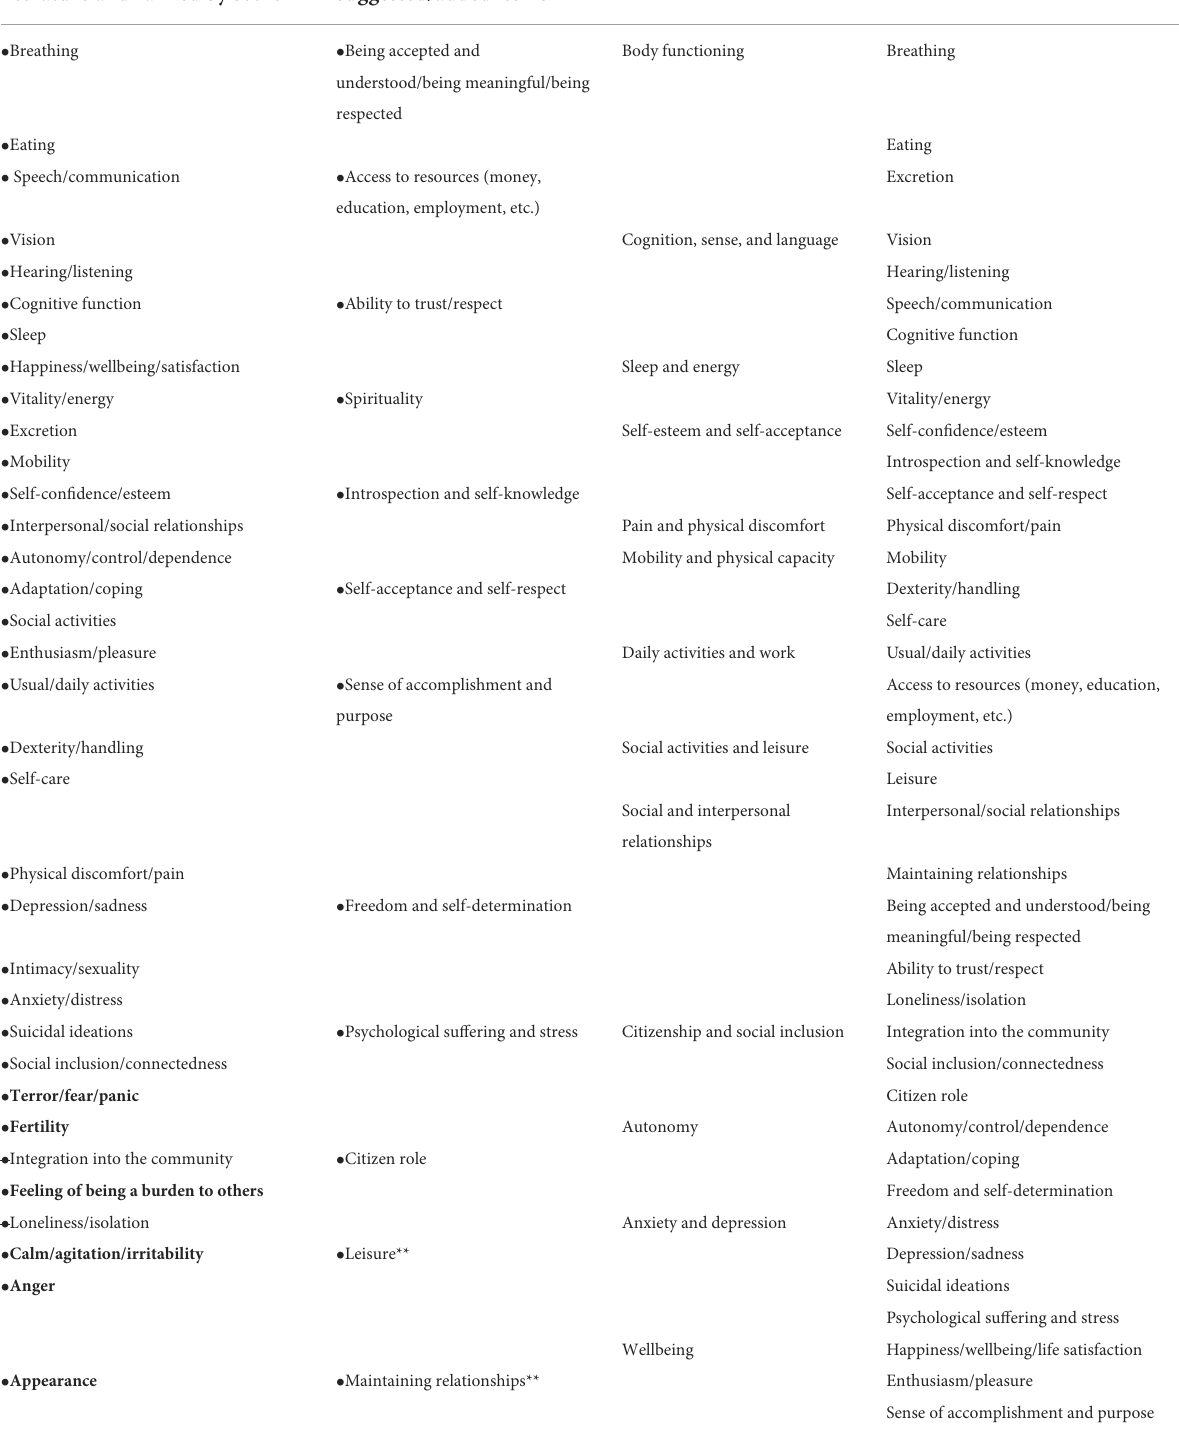
TABLE 2 Meta-dimensions and items retained in round 1 of Delphi. Proposed items from the literature and ranked by